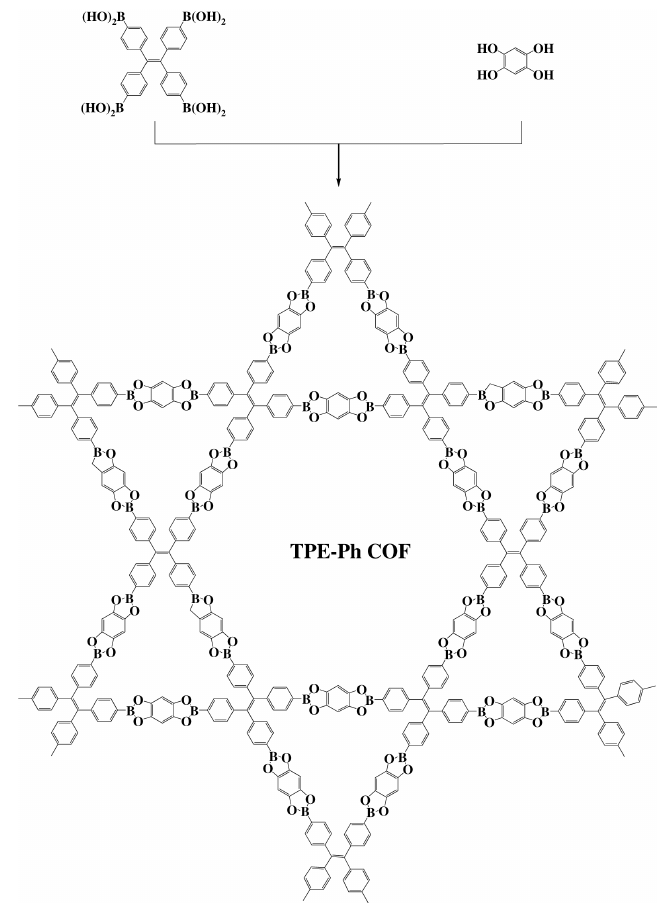
Figure 21: Synthesis and structure of TPE-Ph